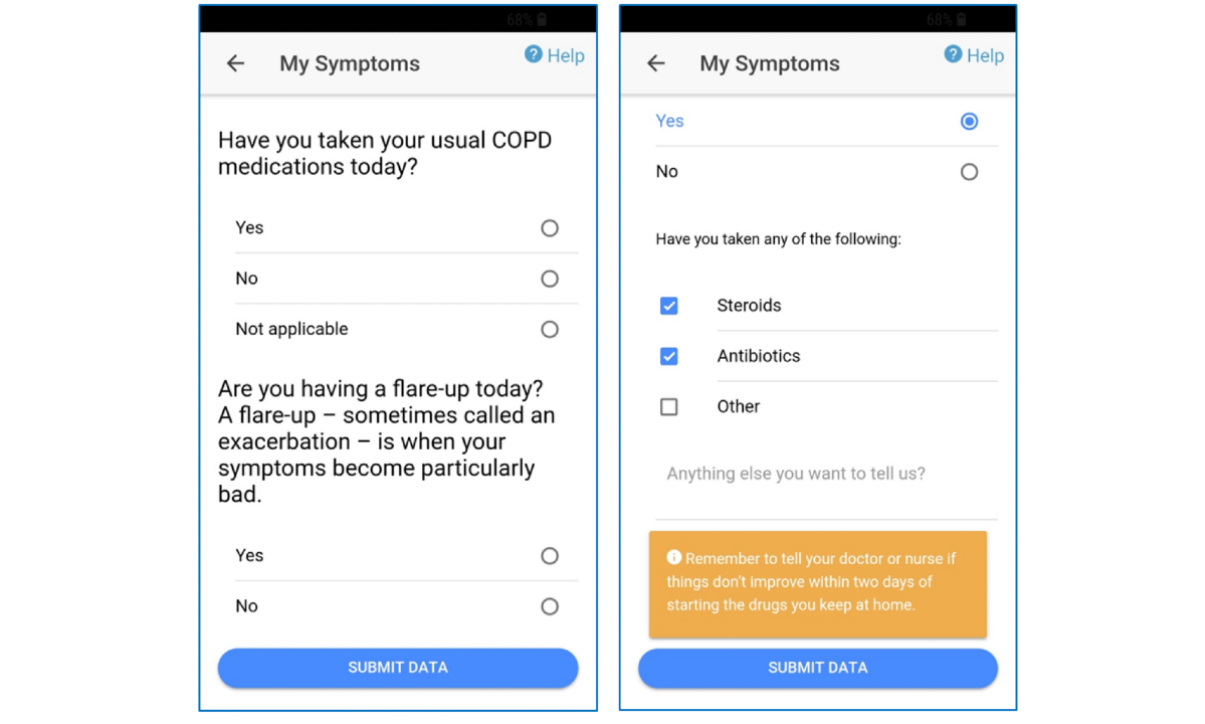
Figure 2. Screenshots of the app pages for medication questions and flare-up